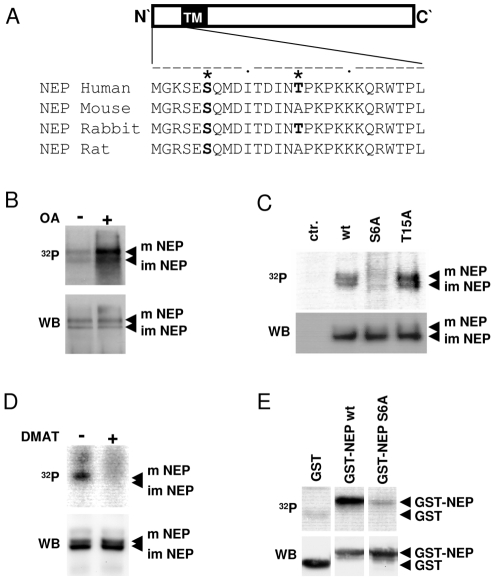
NEP is phosphorylated by CK2 at serine 6.
A, Alignment of the N-terminal amino acid sequences of NEP from several mammalian species. Potential phosphorylation sites predicted by the NetPhos 2.0 server (with score >0.9) are indicated by asterisks. B, C, D HEK293 cells transiently expressing myc-tagged NEP wt or respective mutants were labeled with [32P] orthophosphate in presence or absence of okadaic acid (OA) (B) or DMAT (D) as indicated. After immunoprecipitation, the radiolabeled proteins were detected by autoradiography (upper panels). Subsequently, NEP was detected by immunoblotting with antibody 9E10 on the same membrane (lower panel). E, GST-fusion proteins representing amino acid 1–28 of the NEP N-terminus (GST-NEP) were incubated with CK2 in the presence of [γ-32P]ATP. The radiolabeled proteins were detected by autoradiography (upper panels). Subsequently, GST-fusion proteins were detected by immunoblotting with antibody against GST on the same membrane (lower panel). m = mature; im = immature; ctr. = untransfected cells.